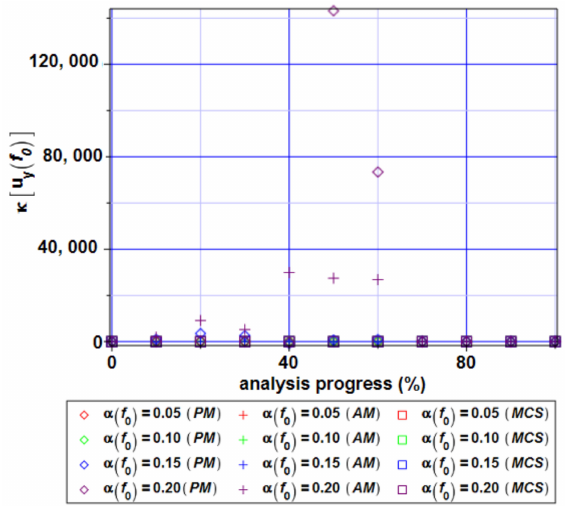
Figure 22. Kurtosis of the extreme vertical displacements κ [u y (f 0 )] for the beam.